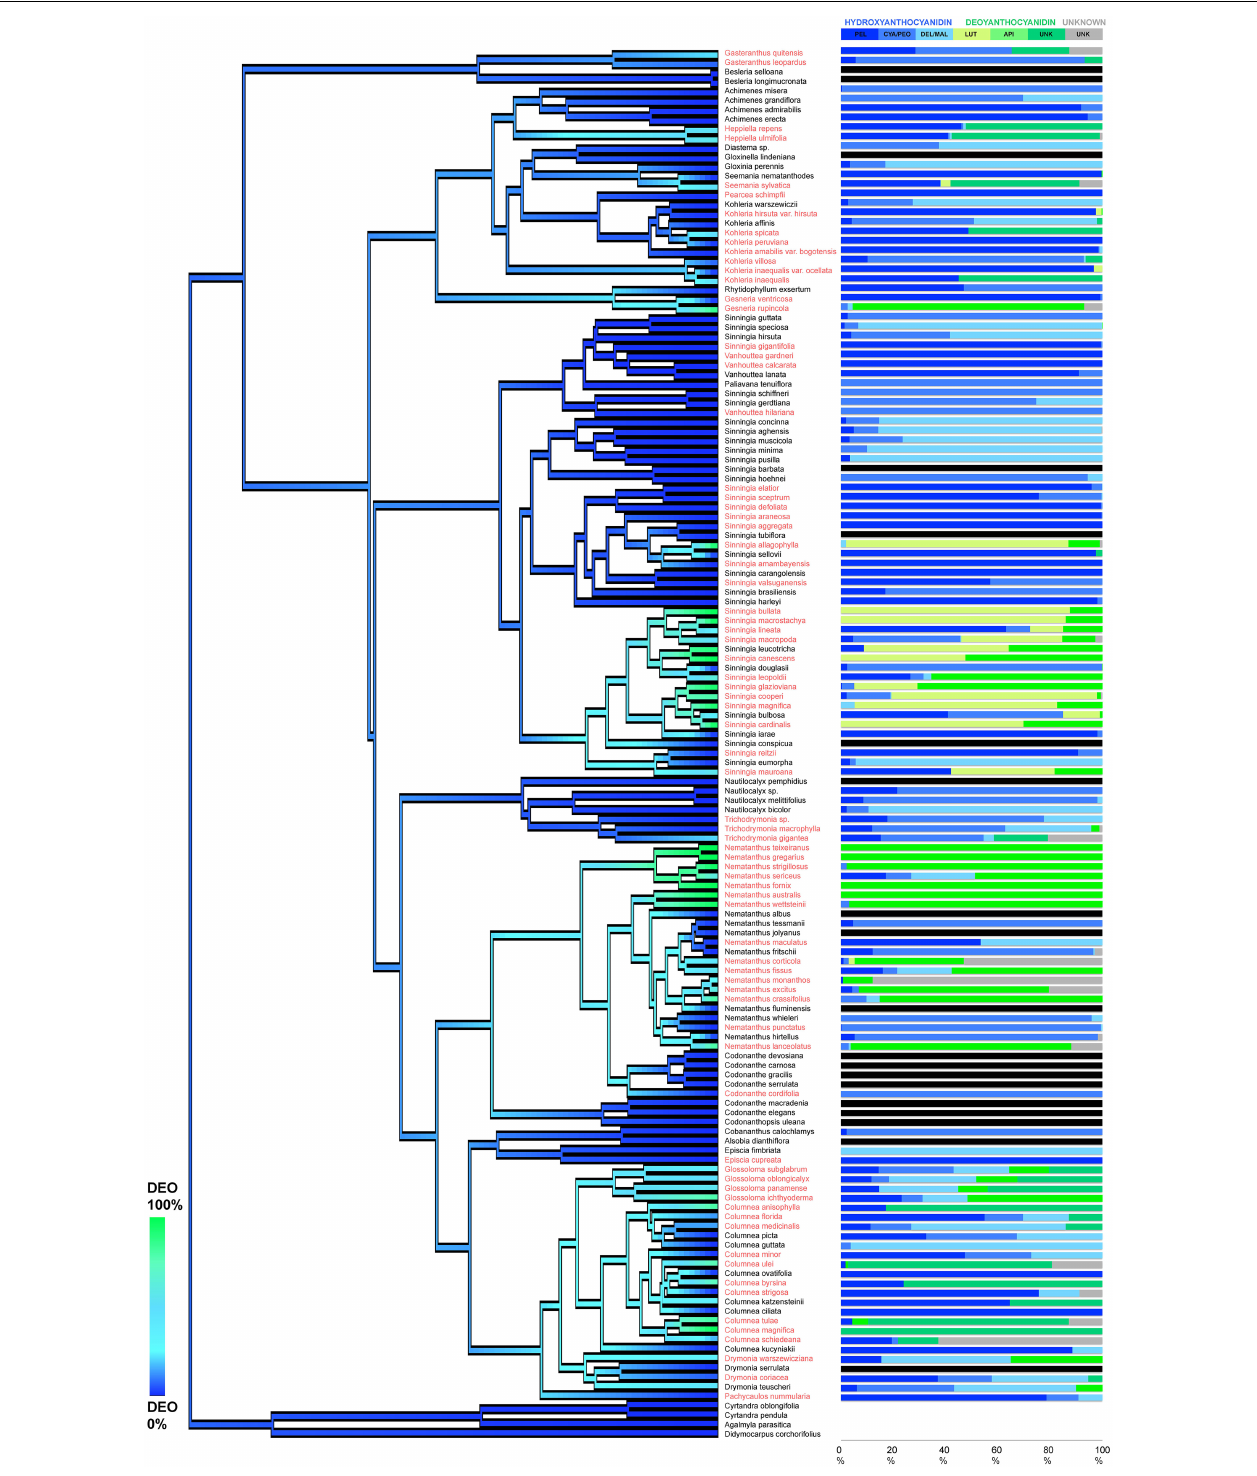
FIGURE 3 | Evolution of deoxyanthocyanin production in the Gesnerioideae. The tree branches are colored based on the reconstructed percentage of the deoxy-anthocyanin presence in the flowers of each species. Species with orange/red flowers are highlighted in red. On the right side of the phylogeny, the percentages of each anthocyanidin are presented in color-coded bars. No-anthocyanin samples are labeled as black bars. PEL, pelargonidin; CYA/PEO, cyanidin and peonidin; DEL/MAL, delphinidin and malvinidin, API, apigenidin, LUT, luteolinidin; UNK (in green): unknown deoxyanthocyanidin; UNK (in gray): unknown anthocyanin. The phylogenetic tree derived from Serrano-Serrano et al. (2017).